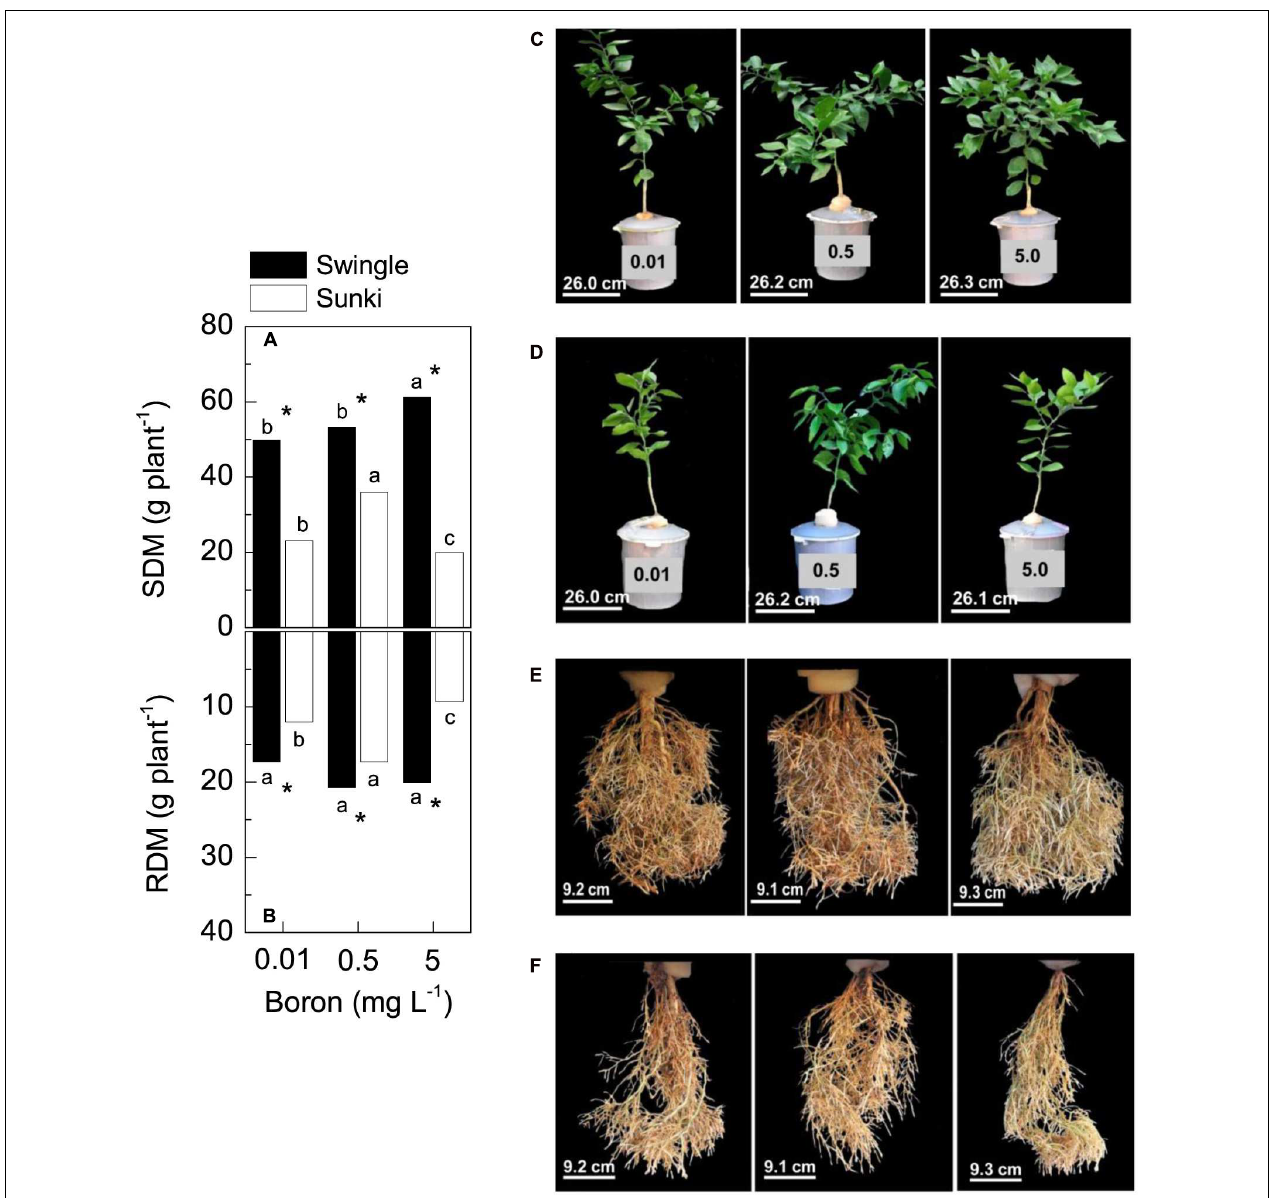
FIGURE 1 | Shoot dry mass (SDM, in A) and root dry mass (RDM, in B) of sweet orange trees grafted on Swingle (C,E) or Sunki (D,F) rootstocks grown in nutrient solution with varying concentrations of boron [C,D, in mg L − 1 , left (0.01), center (0.5), and right (5.0) columns] for 130 days. Asterisks compare rootstocks in a given boron concentration, whereas lowercase letters indicate significant difference between boron concentrations in a given rootstock (Tukey test at p < 0.05).